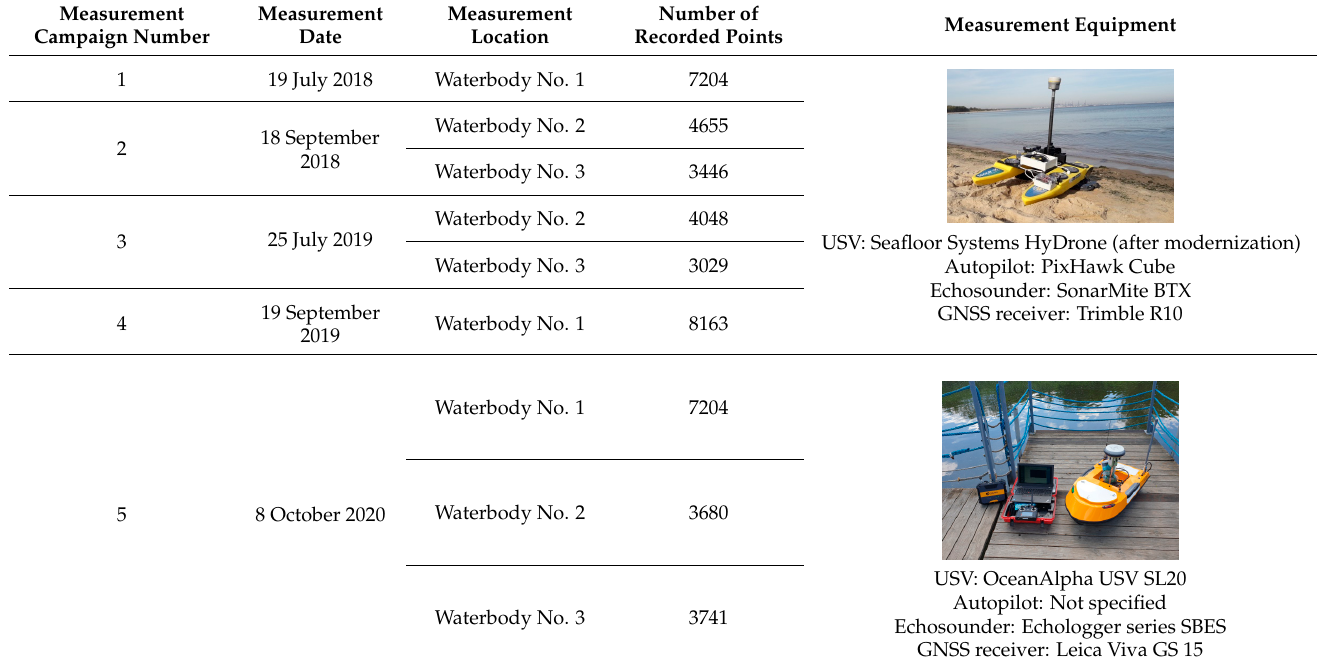
Table 2. Information on the conducted measurement campaigns of the